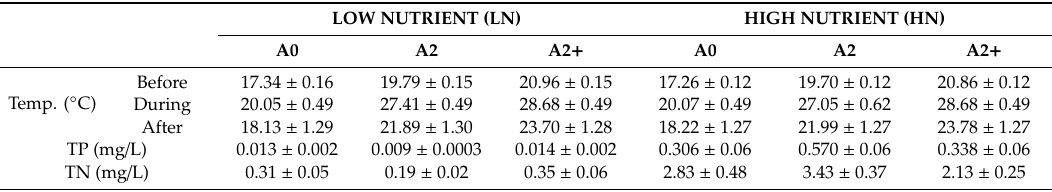
Table 1. Temperature and nutrient measurements of all treatments throughout the study with their standard